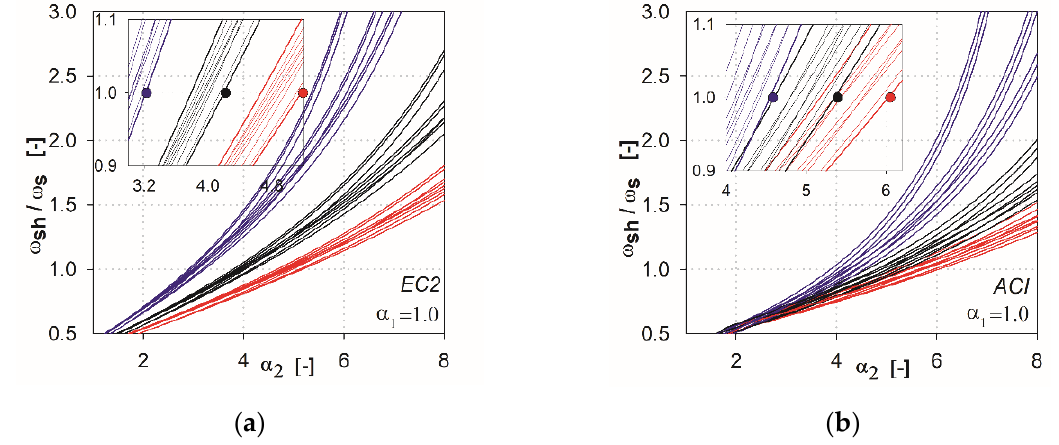
= 0.5: ( a ) for the EC2 standard; ( b ) for the ACI code. 1